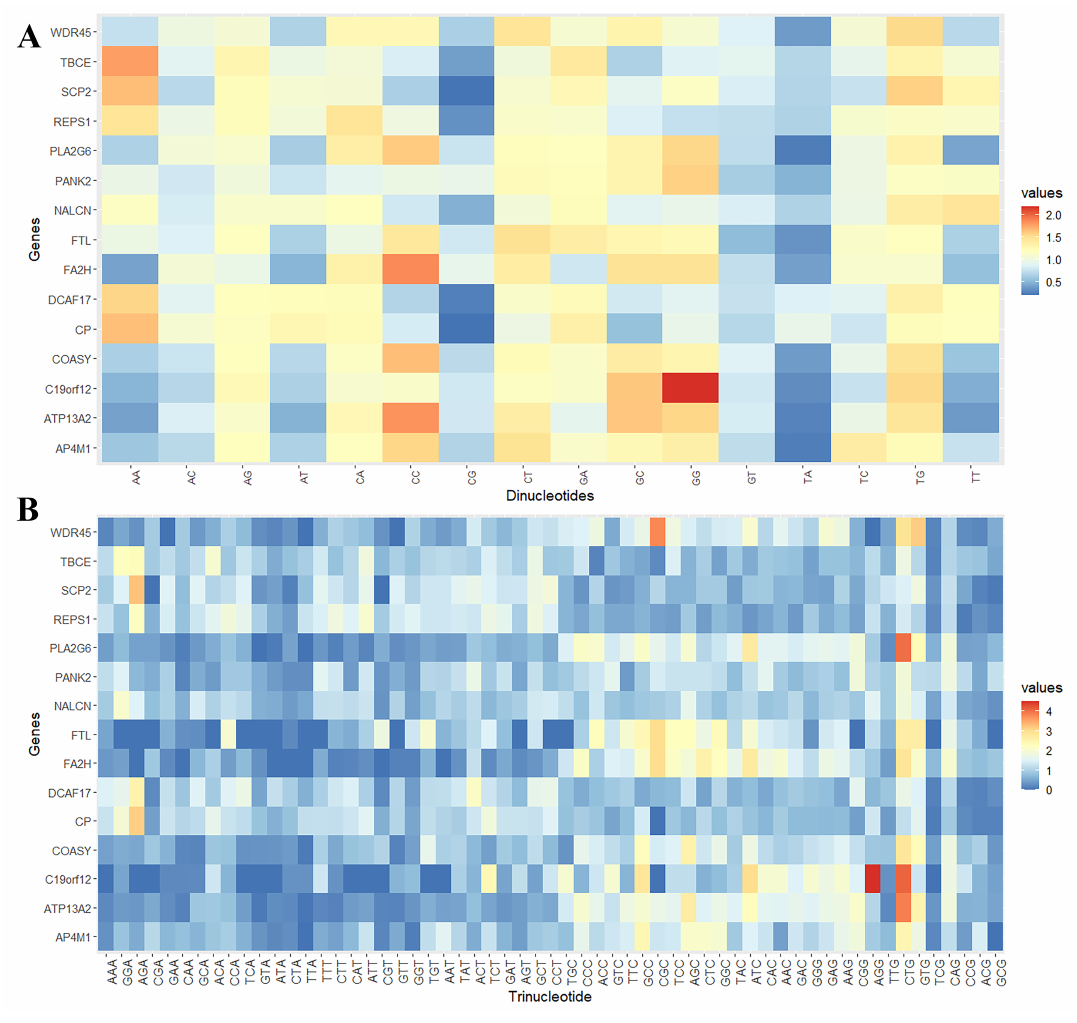
Fig. 4. Heat map for the dinucleotide odds ratio. (A) Each box represents a single gene. Odds ratios are displayed as color-coding, and the color code is given beside the figure. Dinucleotides GpC, GpG, and TpG showed higher odds ratios while ApT, CpG, GpT, TpA and TpT showed lower odds ratios. In the C19orf12 gene, the odds ratio for GpG was reported highest. (B) Each box represents a single gene. RSCU values are displayed as color-coding, and the color code is given on the side of the figure. The left side of the heat map displays A/T ending codons, while the right-side displays C/G ending codons. CTG codon is overrepresented, while TA and CG ending codons are